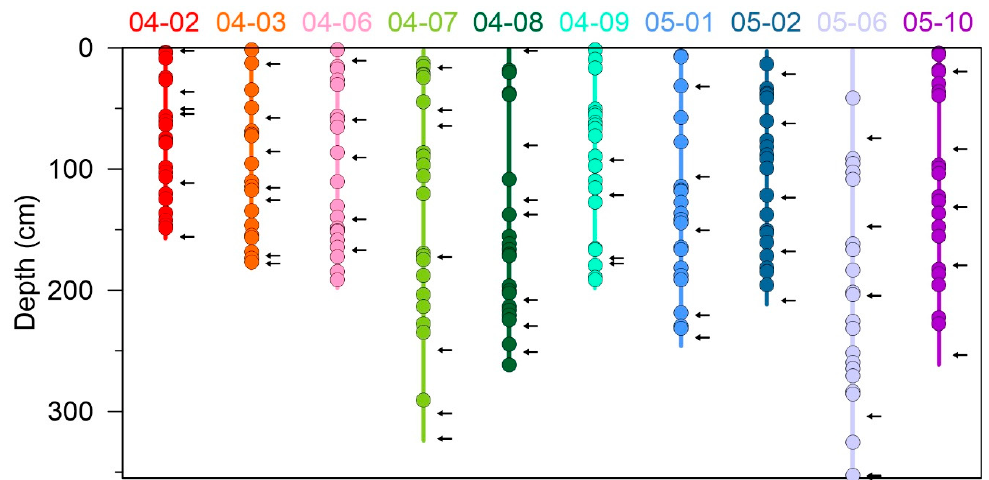
Figure 3. Distribution of randomly selected samples in sediment cores from 10 lakes, plotted against depth below the top of each core. Because cores were artificially truncated, core tops do not always correspond with the modern sediment-water interface. Colored lines in background denote the length of each core. Black arrows note 14 C age control in each core. Radiocarbon ages and resulting depth-age models are presented in (Munroe, GSA Bulletin, in press).